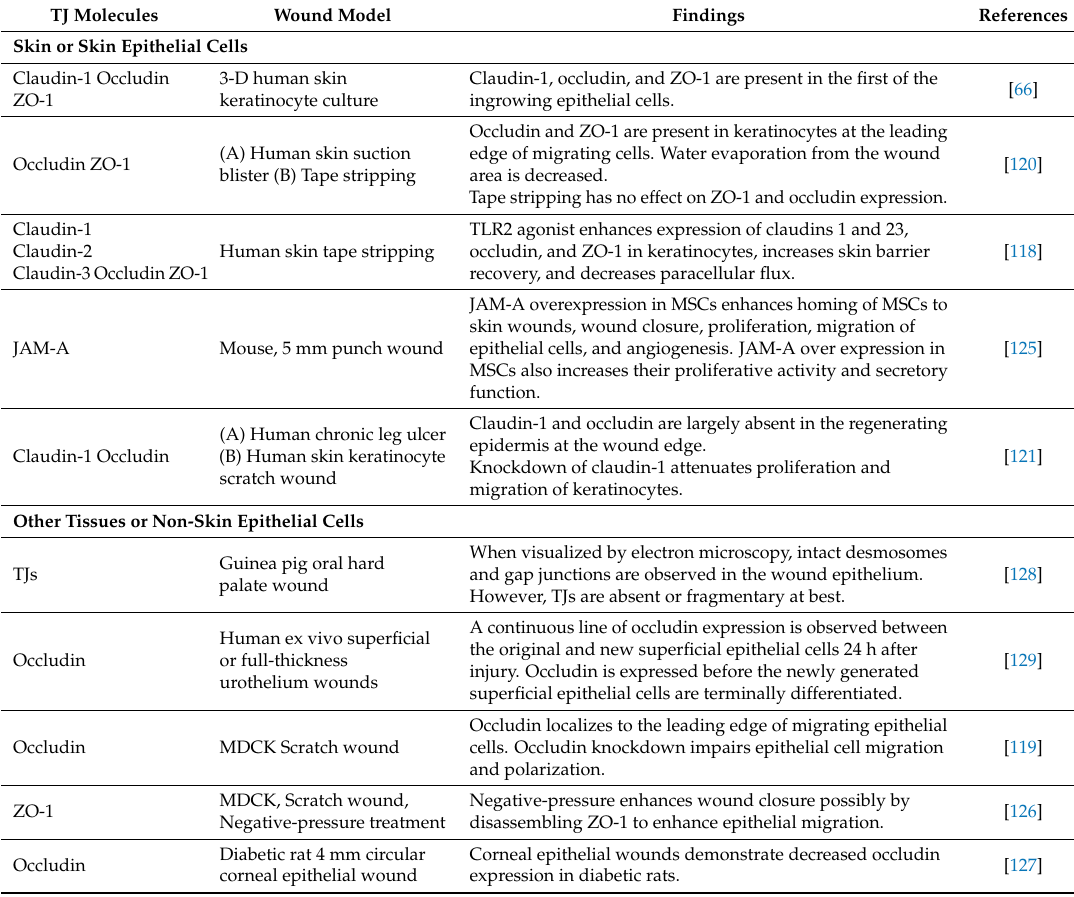
Table 3. Summary of findings regarding bi-cellular tight junction molecules in various wound